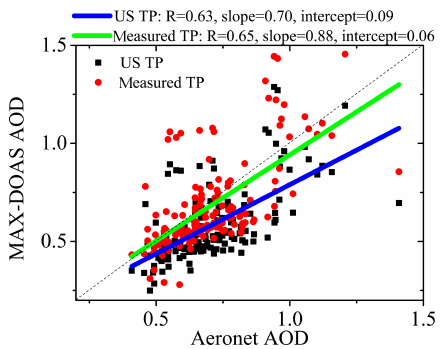
Figure 4. AODs retrieved from MAX-DOAS observations (using either the US standard summer TP profile or the explicit TP from measurements) plotted against those from the Taihu AERONET sta- tion for clear-sky conditions. The results of the linear regressions are shown on top of the diagram.